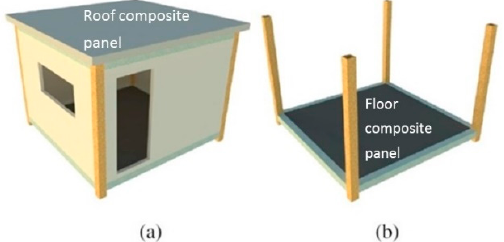
Figure 13. Schematic of the modular prototype: ( a ) full prototype; ( b ) prototype without walls and roof. Adapted from [56].